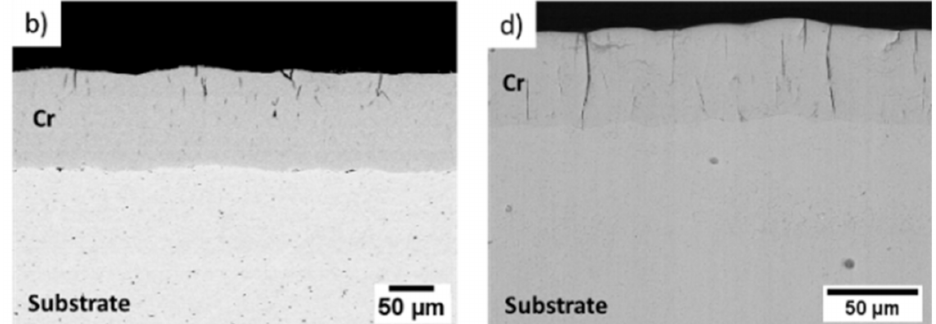
Figure 2. SEM microstructural observations in surface and cross section of deposits: ( a , d ) hexavalent chromium, ( c , d ) trivalent